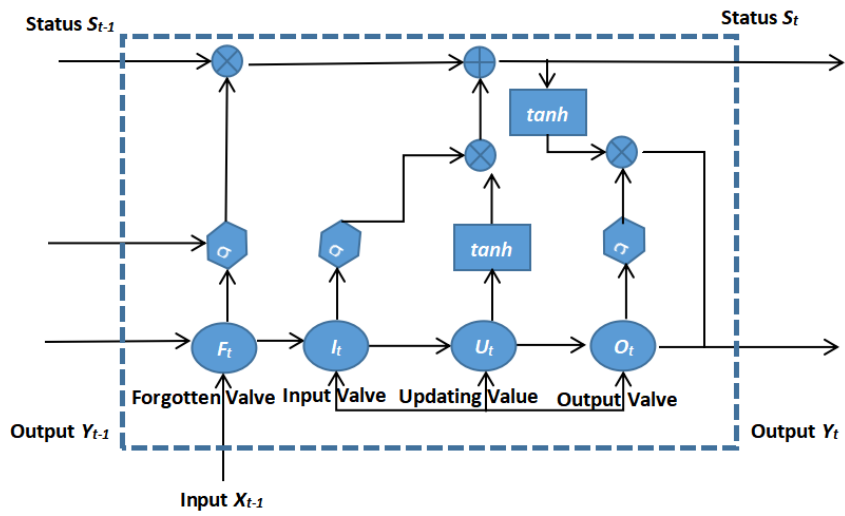
Figure 5. Model structure of